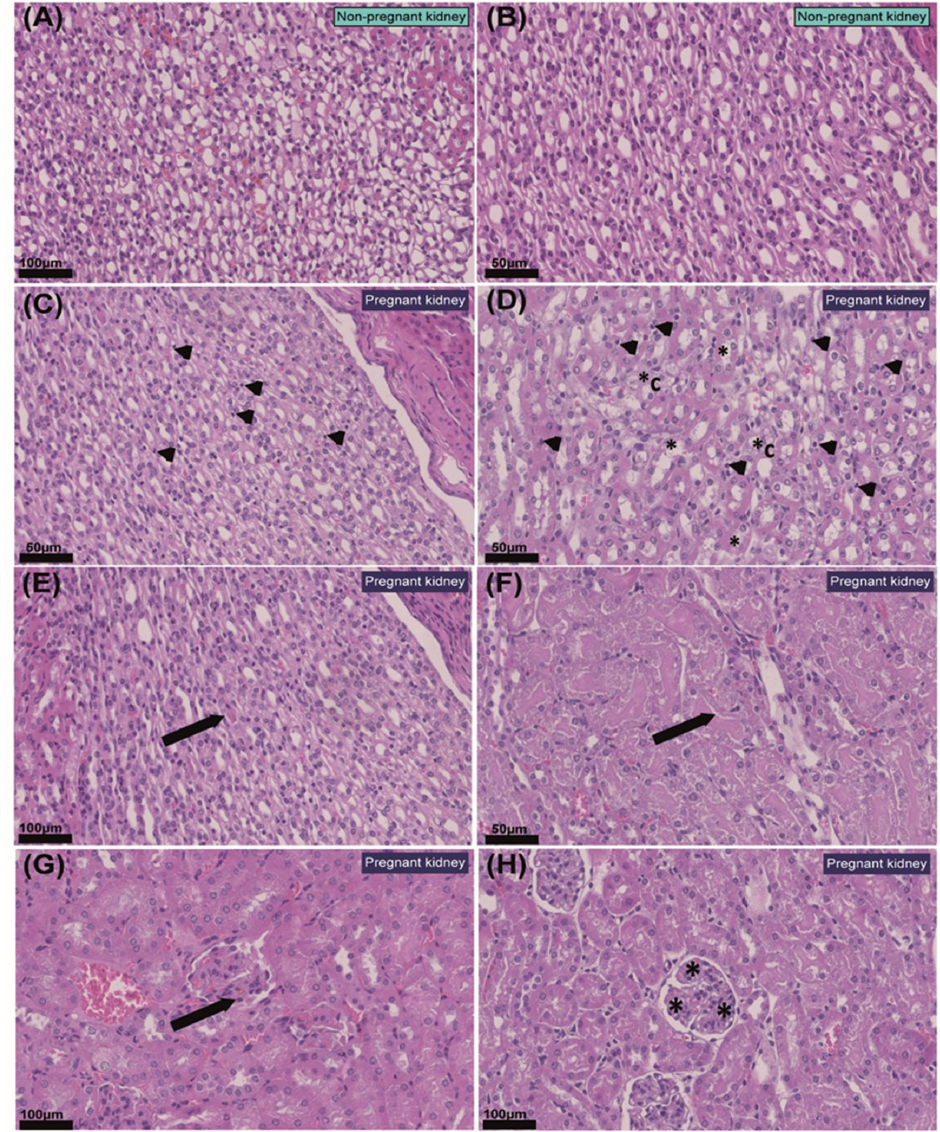
Figure 2. Histopathological changes in the kidney in response to pregnancy in mice. ( A , B ) Representative images of non-pregnant renal medulla. ( C ) Renal medulla of pregnant mouse with mildly increased numbers of interstitial cellular constituents (arrow heads). ( D ) Renal medulla of pregnant mouse with moderately increased numbers of cells within the interstitium (arrow heads), distal tubule epithelial degeneration (*) and collecting duct epithelial degeneration (*C). ( E ) Protein casts within proximal tubules with mild degeneration in the renal cortex of a pregnant mouse (arrow). ( F ) Protein casts within distal tubules in renal medulla of a pregnant mouse (arrow). ( G ) Segmental thickening of the glomerular basal membrane in pregnant kidney (arrow). ( H ) Mild glomerular splitting in pregnant kidney (*). Values of scale bars are shown in the images.